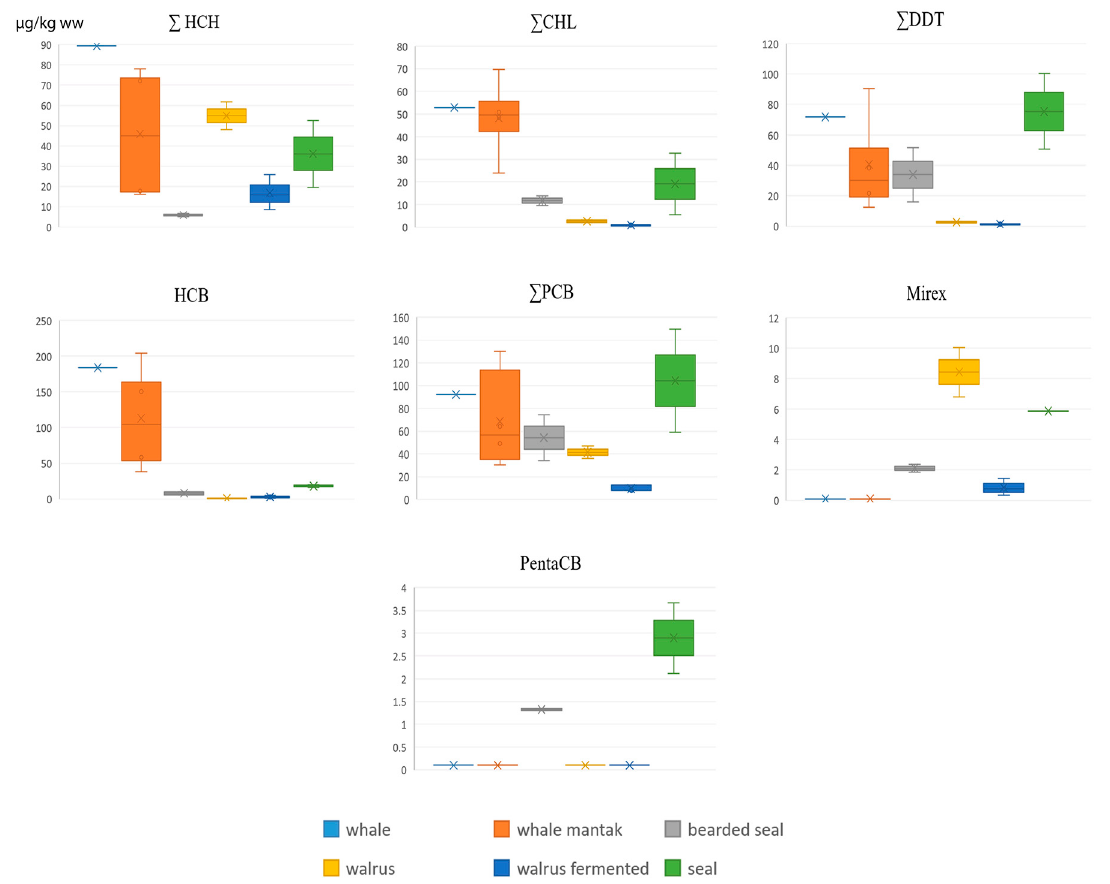
Figure 2. Concentrations of POPs in blubber of marine mammal species, µg/kg ww.